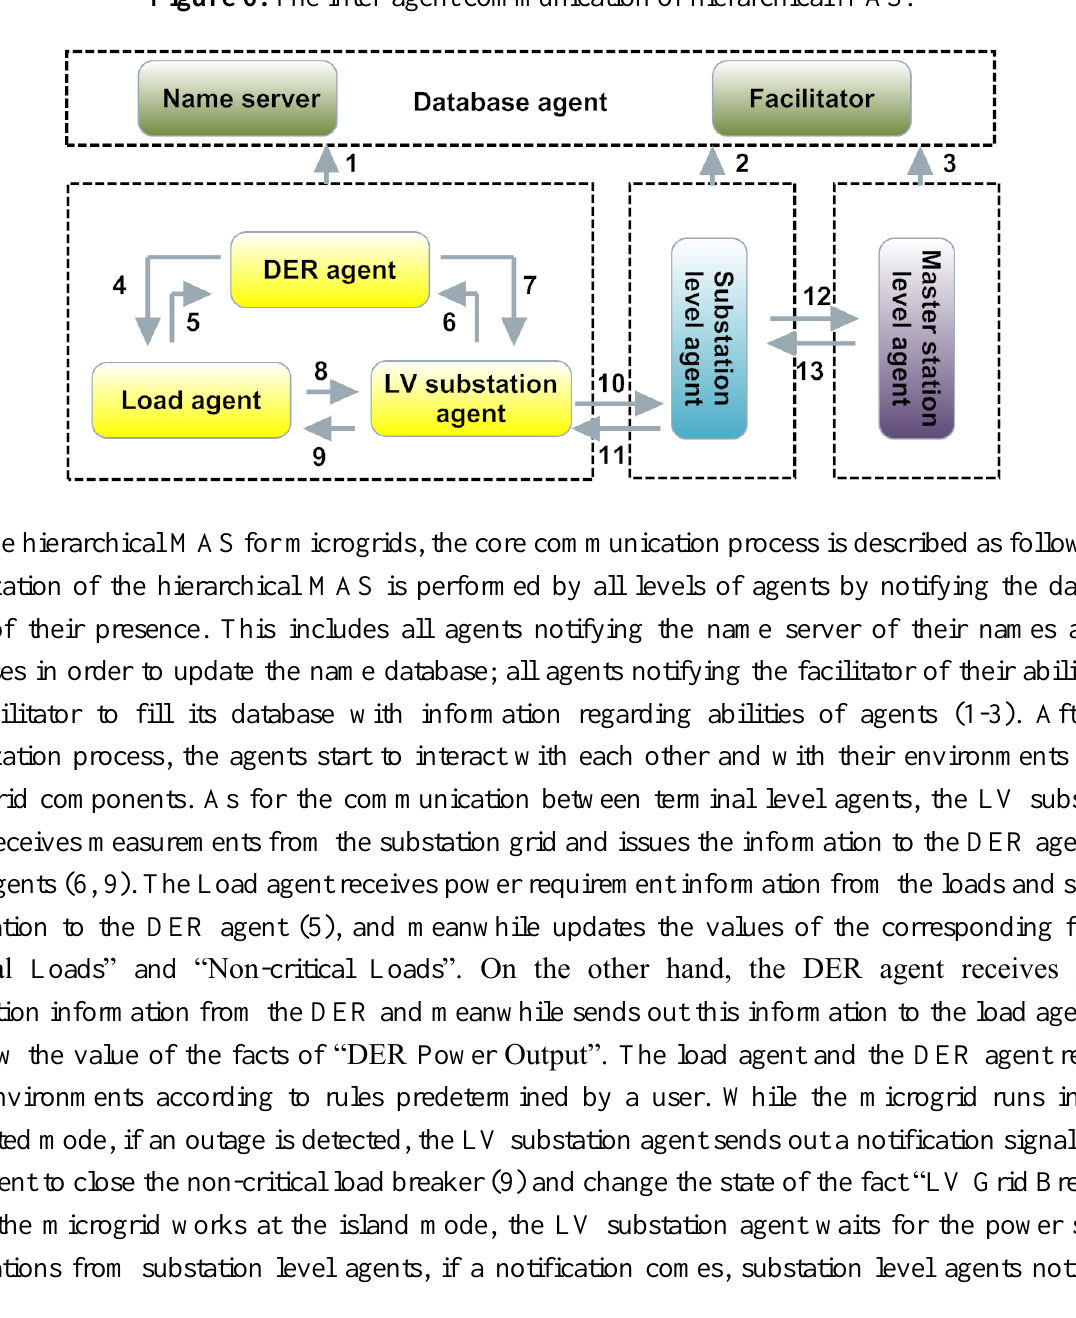
Figure 6. The inter-agent communication of hierarchical